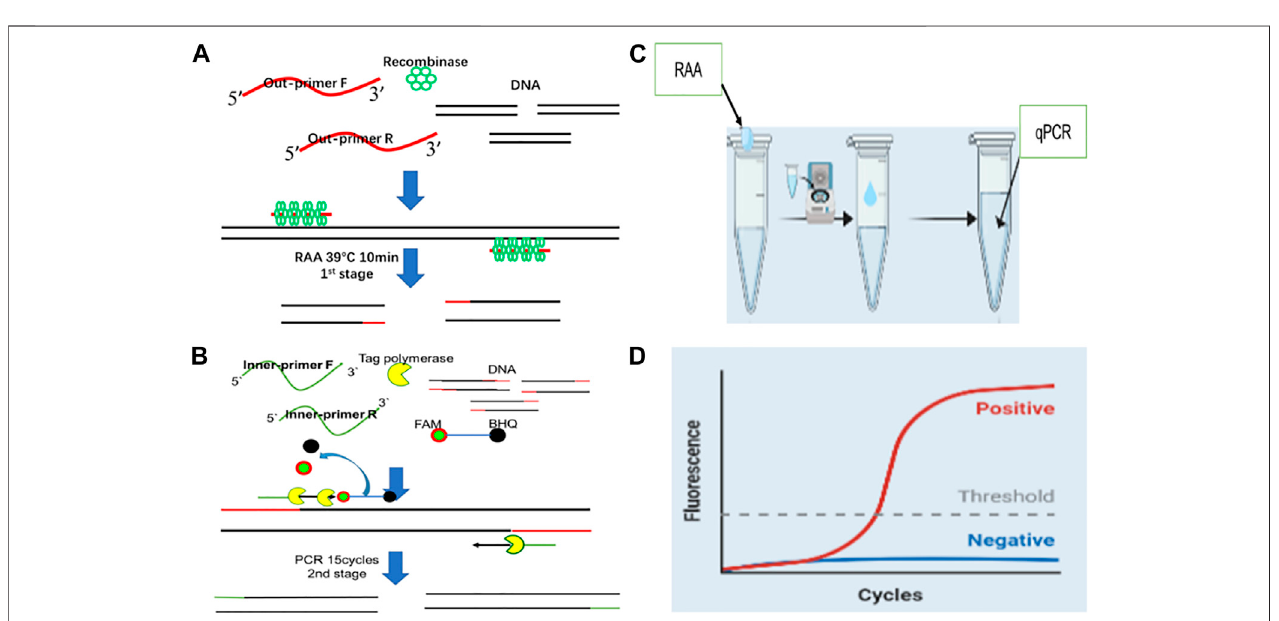
FIGURE 1 | The working principle of Recombinase Aided PCR (RAP) (A) : RAA for 10 min at 39 ° C ( fi rst stage of RAP). (B) : qPCR 15 cycles (second stage of RAP). (C) : The reaction tube comprises two compartments. The tube lid (inner surface) compartment contains the RAA mix and the tube bottom compartment houses the qPCR mix. (D) : The results can be exhibited by real-time fl uorescence curves with qPCR machine.